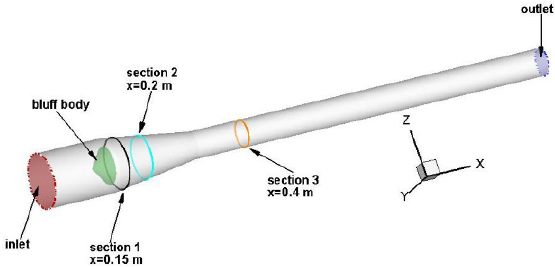
Figure 3. Computational domain with the sections for investigating velocity